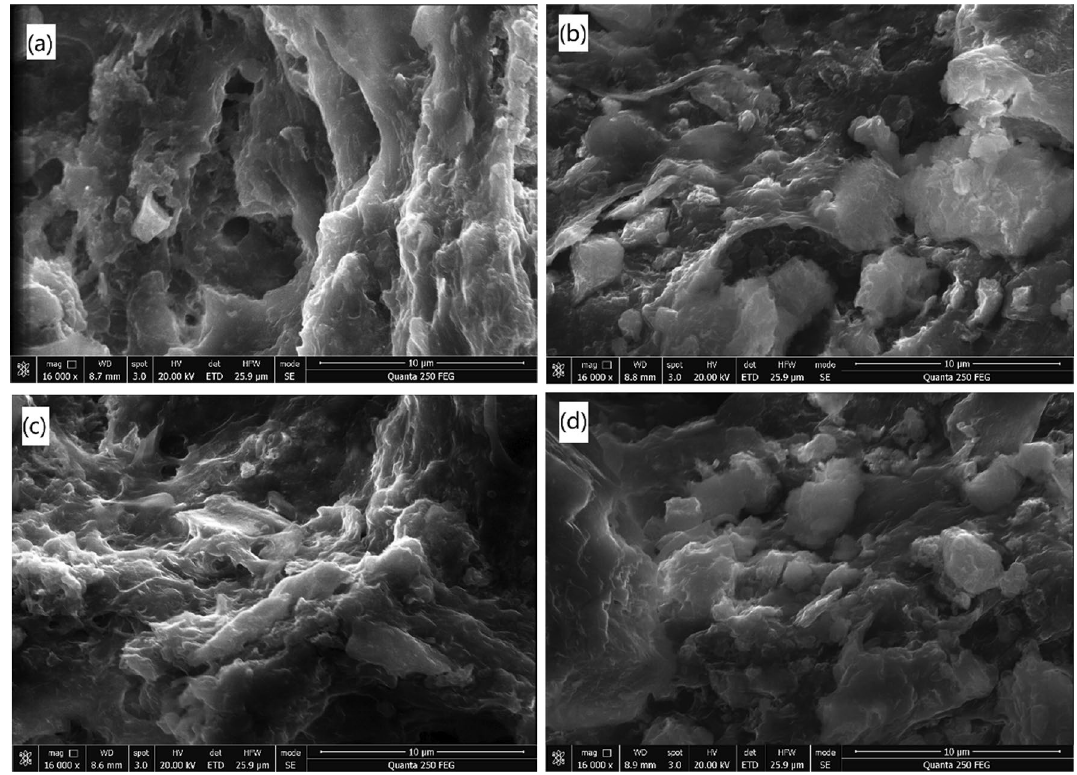
Figure 6. SEM images of sludge flocs: ( a ) raw sludge and conditioned by ( b ) ATP, ( c ) St-CTA, and ( d ) St-CTA in conjunction with ATP at respective optimal dose, that is, St-CTA is 16.00 mg/gTSS and ATP is 14.00 kg/m 3